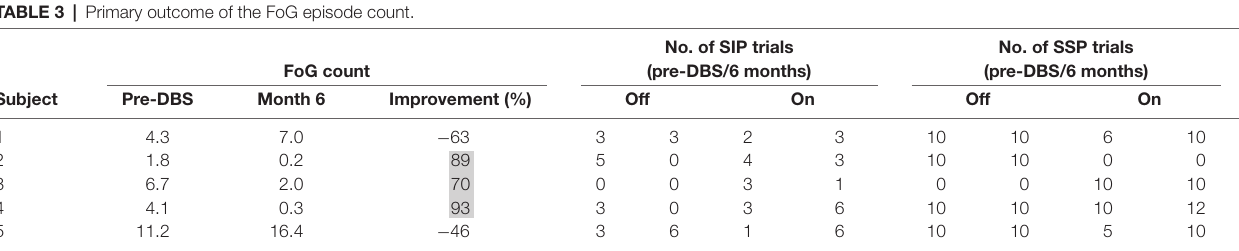
TABLE 3 | Primary outcome of the FoG episode